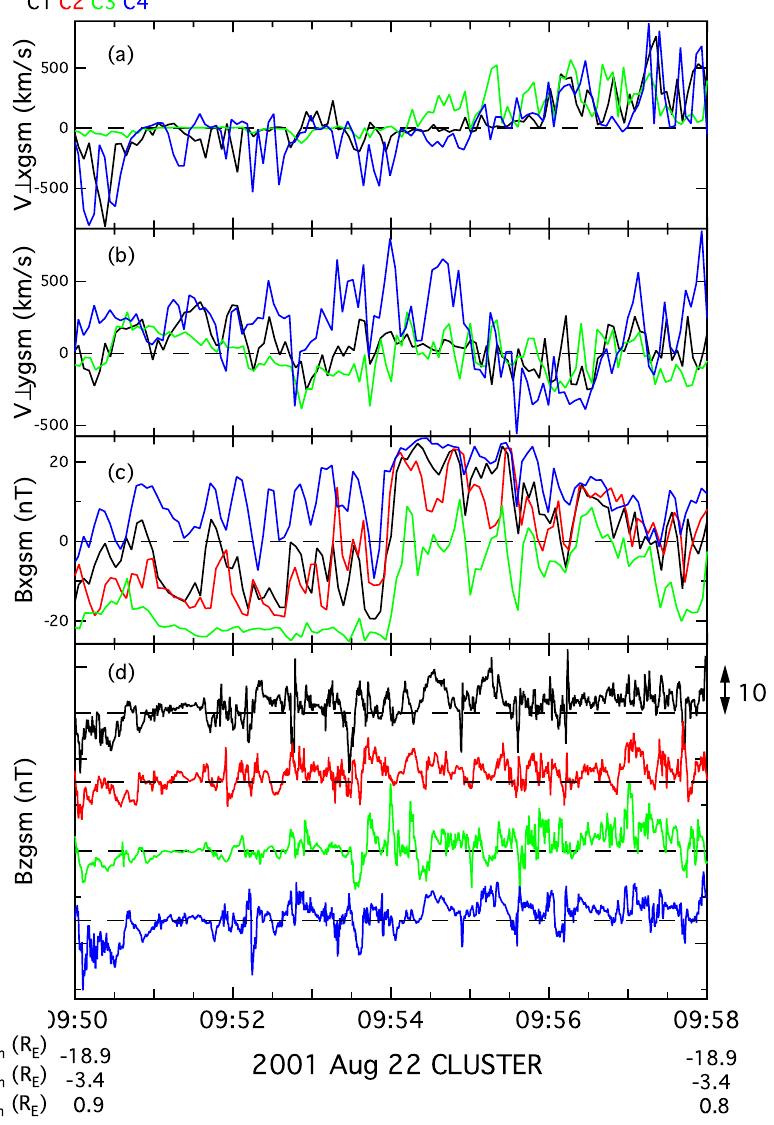
Fig. 4. Cluster observations of plasma flow reversal and the associated magnetic field reversal.